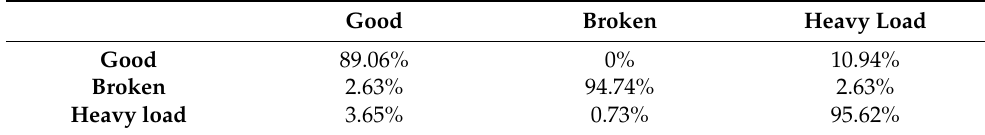
Table 10. Confusion matrix of the Edge Impulse